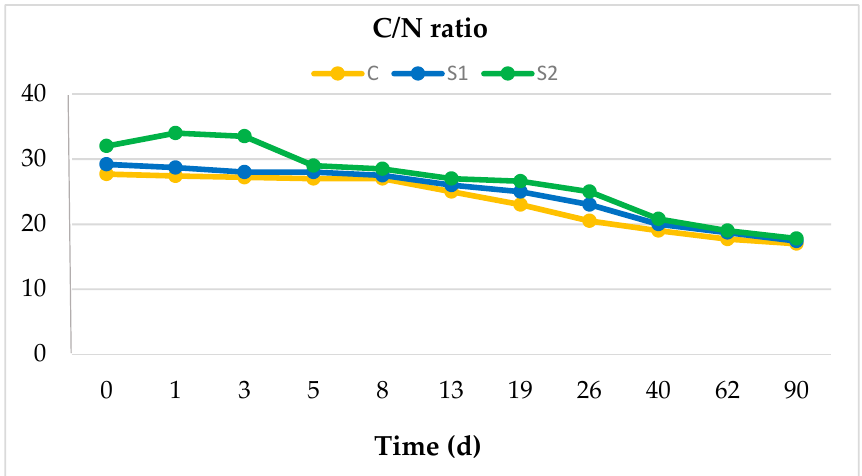
Figure 4. Changes in C/N ratio during composting.